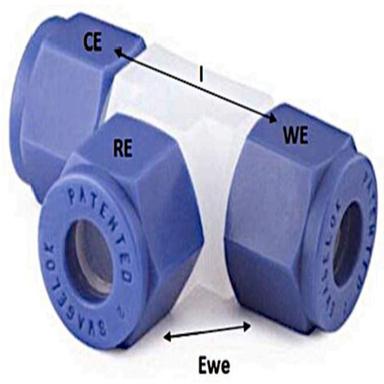
Swagelok® T three-electrode cell.